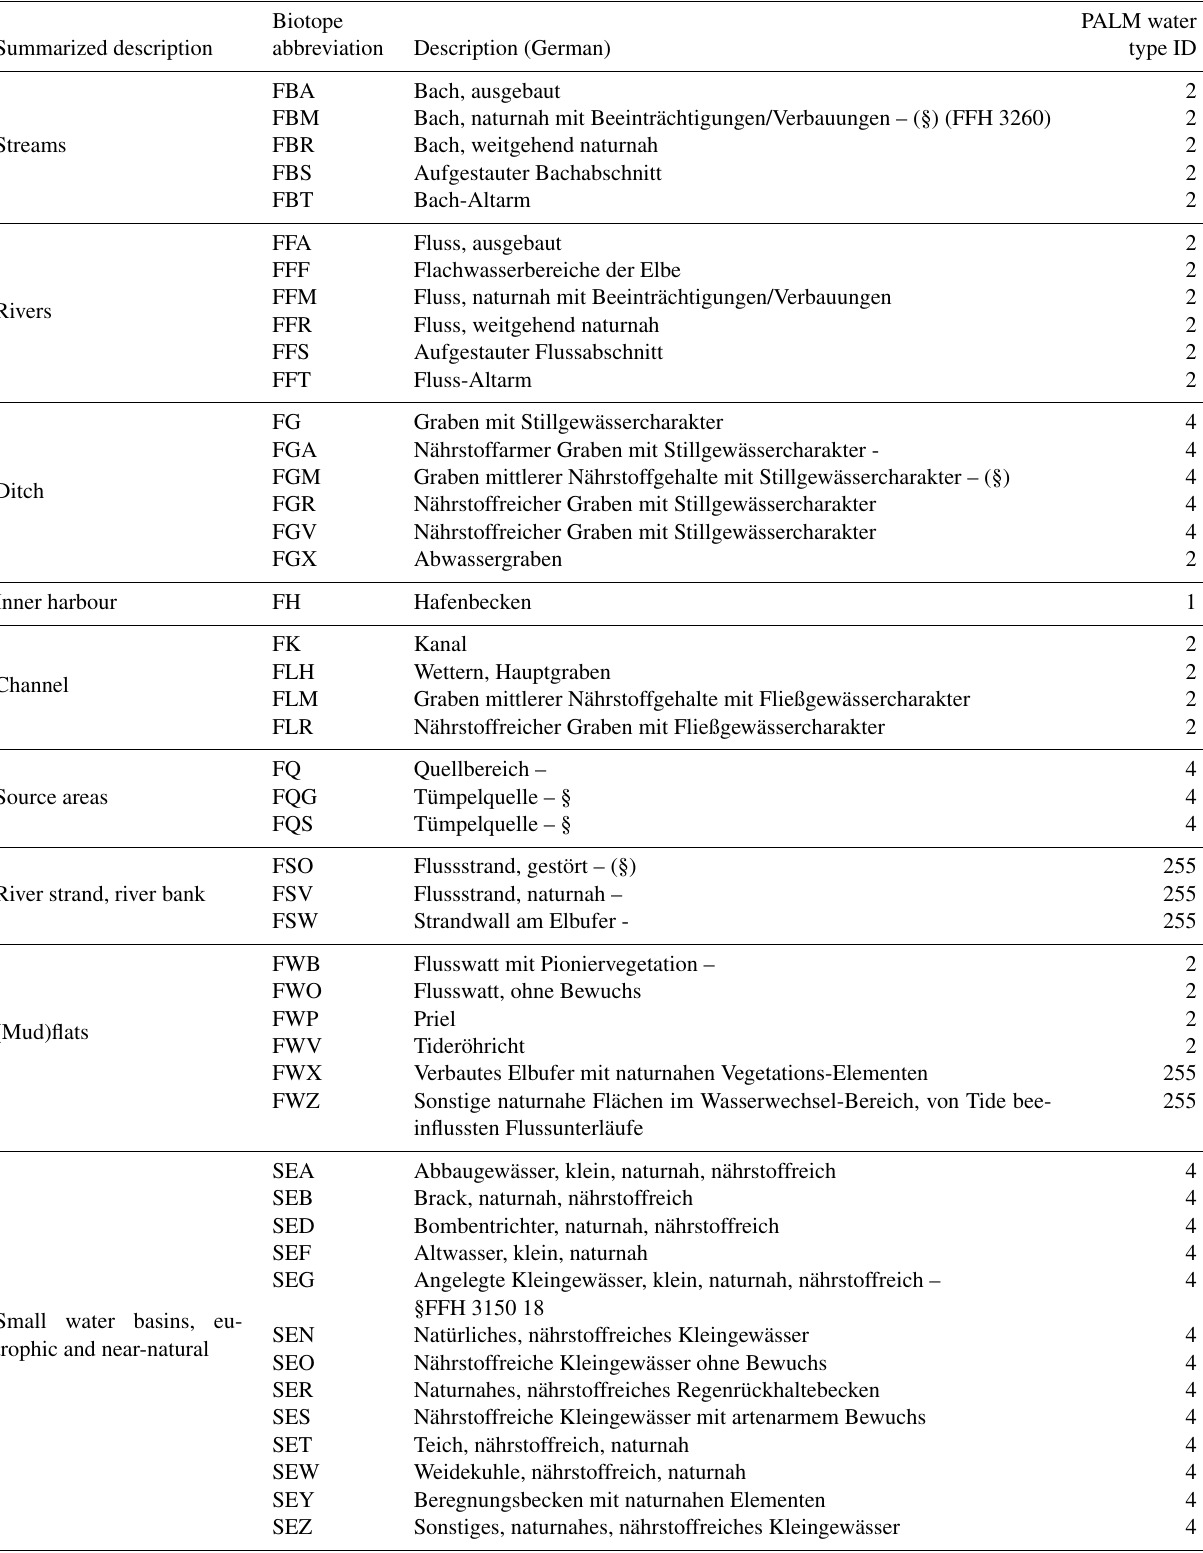
Table B11. Biotope types of Hamburg to PALM water